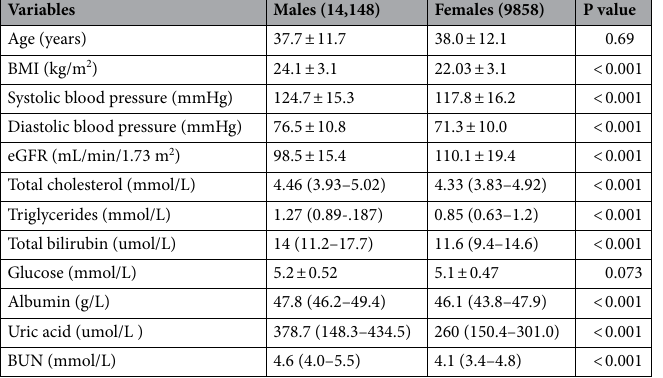
Table 1. Descriptive data of the study population. BMI body mass index; eGFR estimated glomerular filtration rate.